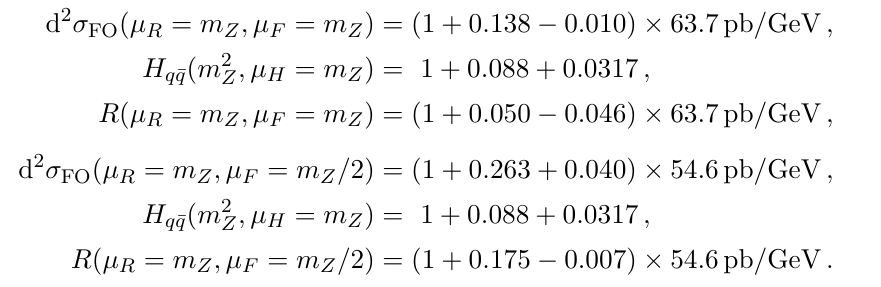
The perturbative series of the (cid:12)xed-order cross section at Q = m decomposition into hard function H given